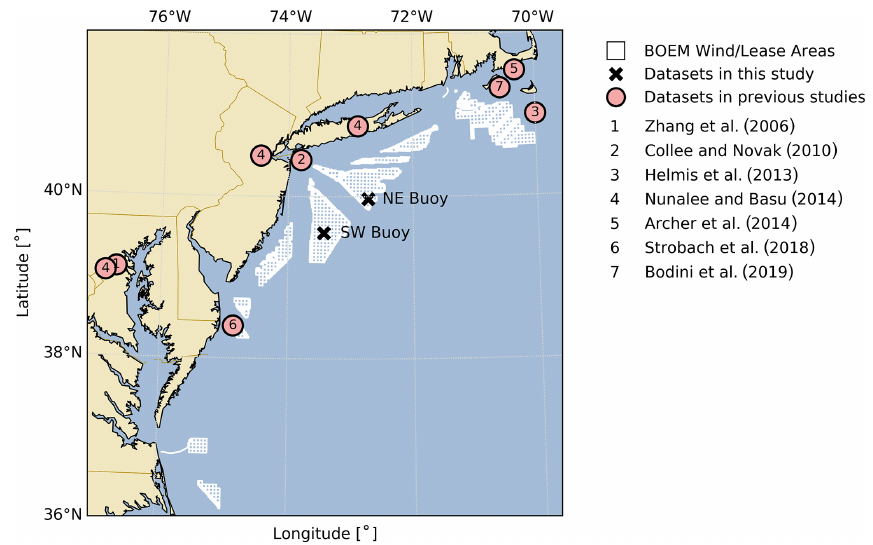
Figure 1. Map of US North Atlantic and mid-Atlantic OCS showing Bureau of Ocean Energy Management (BOEM) lease areas and wind planning areas in white (accurate as of April 2020), the two floating lidar measurement locations (black crosses), and approximate measurement locations of previous studies focused on the offshore wind resource in this region (red